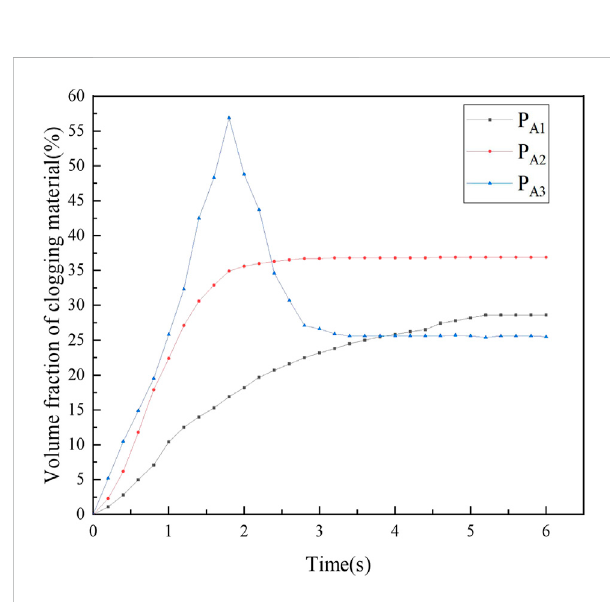
FIGURE 14 Clogging development of different aggregate